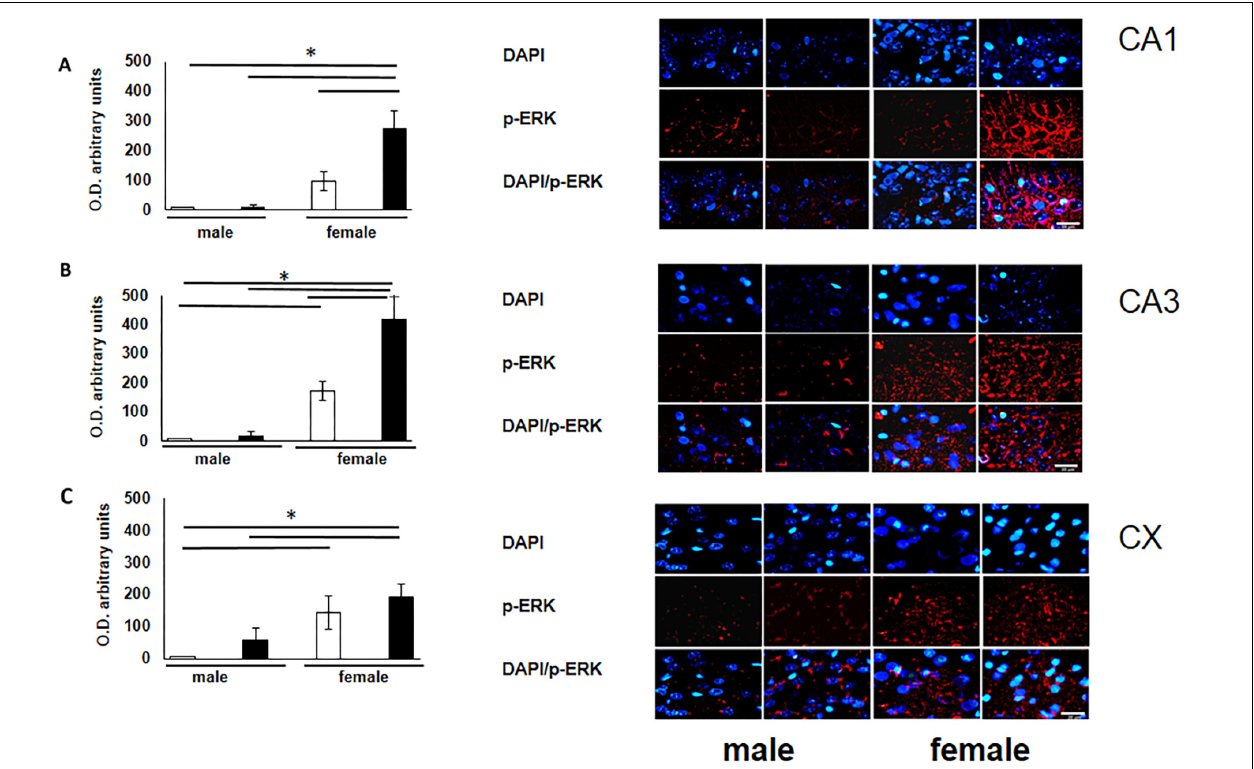
FIGURE 5 | Representative microphotography (objective 60 × and zoom 1.6 × ) showing immunopositivity for the p-ERK (red) and DAPI-stained nuclei (blue). The graph indicates optical density arbitrary units for control group (white bars) and ozone group (black bars) in male and females, (A) CA1, (B) CA3 and (C) CX. Expression of p-ERK is significantly increased in three structures (CA1, CA3, and CX). Bars indicate the mean ± SEM, using univariate comparison statistics. ∗ P ≤ 0.05. Scale bar = 20 µ